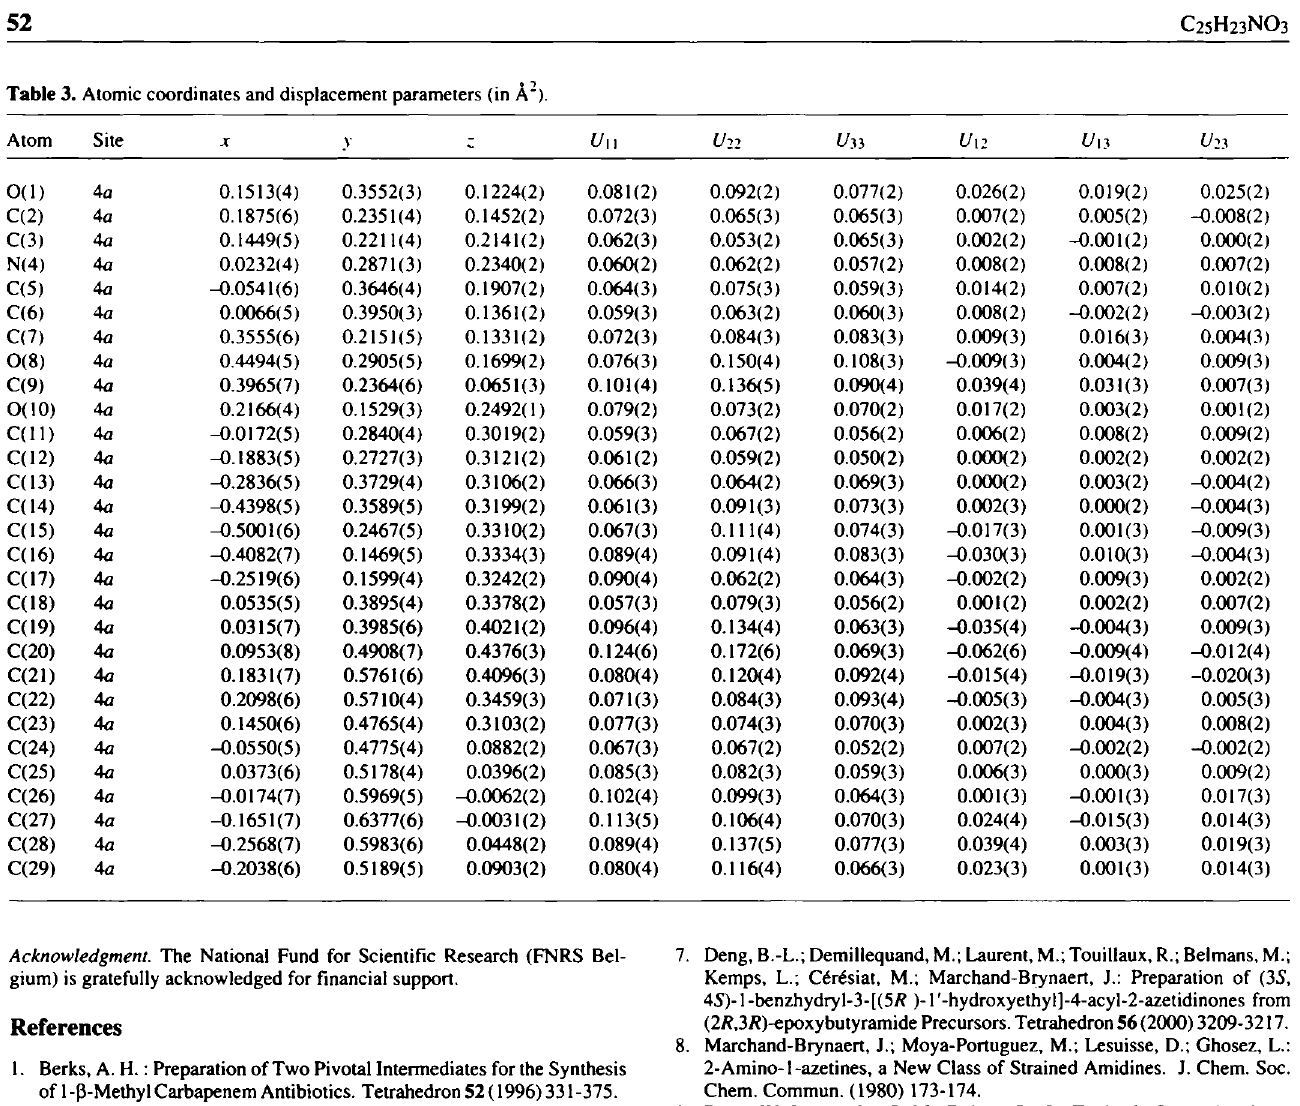
Table 3. Atomic coordinates and displacement parameters (in